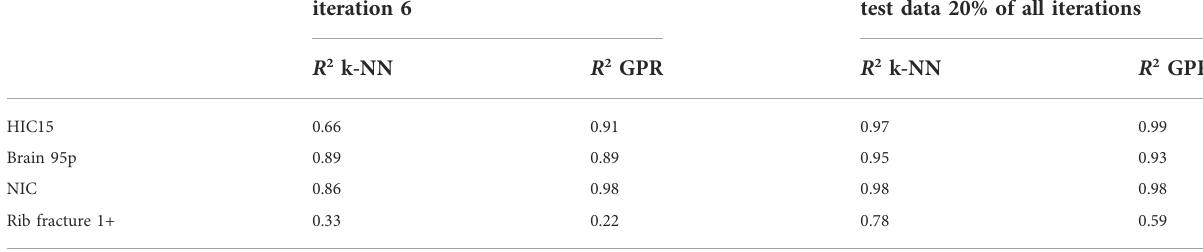
TABLE 4 R 2 values for predictions with k-NN and GPR metamodels for two different splits into training data and test